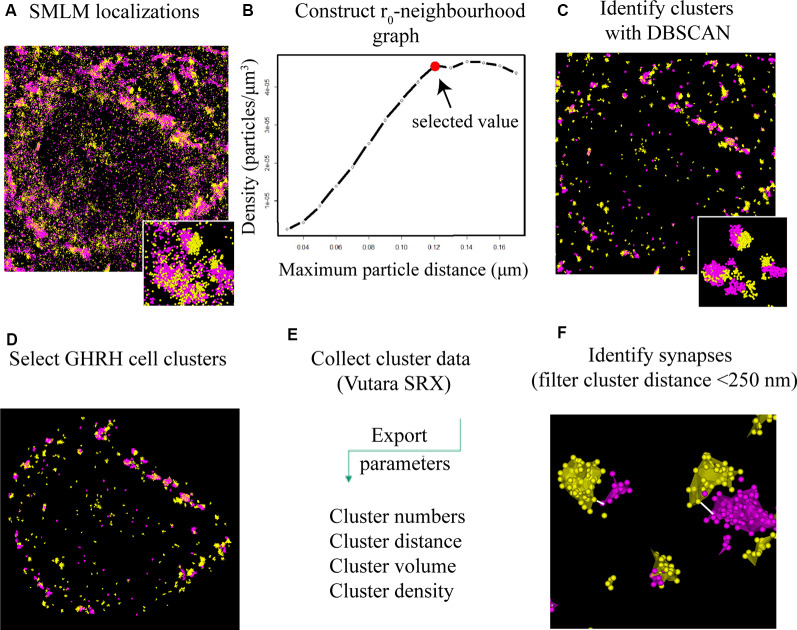
DBSCAN extraction of synapses from SMLM localization data. (A) All single molecule localization microscopy (SMLM) localizations of VGLUT2 (magenta) and PSD95 (yellow), displayed as a pointcloud visualization. The data contains clusters (synaptic and non-synaptic) and single localizations (non-clustered proteins, unbound antibodies). (B) Serial parameter scan for DBSCAN: the mean value of the localization density per identified cluster is plotted against the increasing DBSCAN distances (r0) while the minimum particle count is kept constant to 6. The plateauing curve indicates stable clustering parameter. We choose the beginning of the plateau as the ideal r0 value for the specific protein population. (C) DBSCAN algorithm filters data based on the input parameters and displays resulting clusters. (D) Synaptic clusters associated with a GHRH cell are selected manually (based on an overlay with a GHRH reference image, as shown in Figure 3B). (E) Various quantitative cluster data of interest is exported to an Excel file. (F) An in-house-built algorithm for the software “R” filters full synapses based on their inter-cluster distance between pre-and post-synaptic clusters of <250 nm.